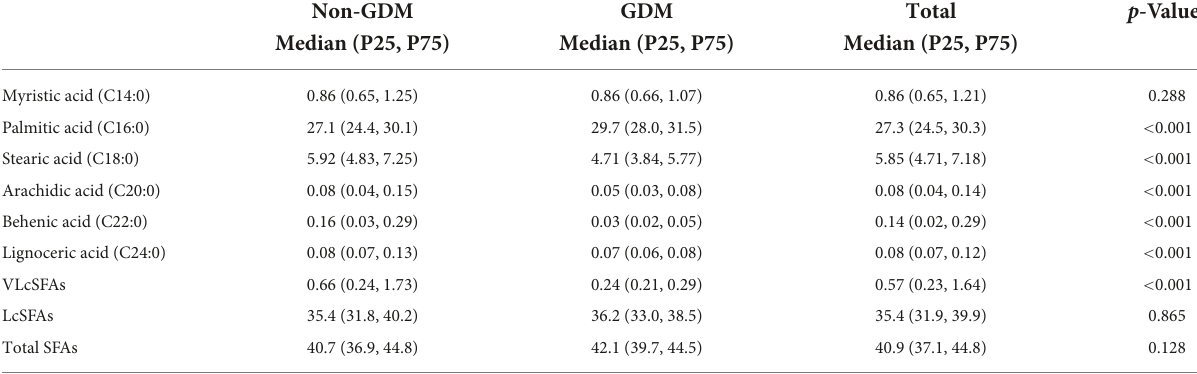
*ThedataofGDMandnon-GDMpregnantwomenwerecomparedbyMann–Whitneytests. TABLE 3 The correlation of various SFAs in the cross-sectional study.